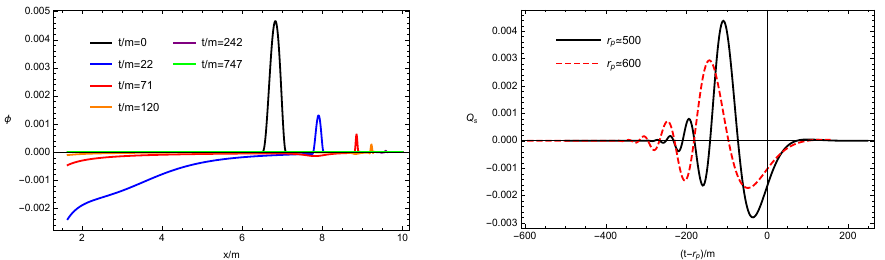
Figure 4 . The temporal evolutions of the scalar field for an initial BBH with a mass beyond the threshold value. Left panel: spatial distribution of the scalar field φ at different time slices. Right panel: the scalar charge Q s as a function of t r p at large r p −